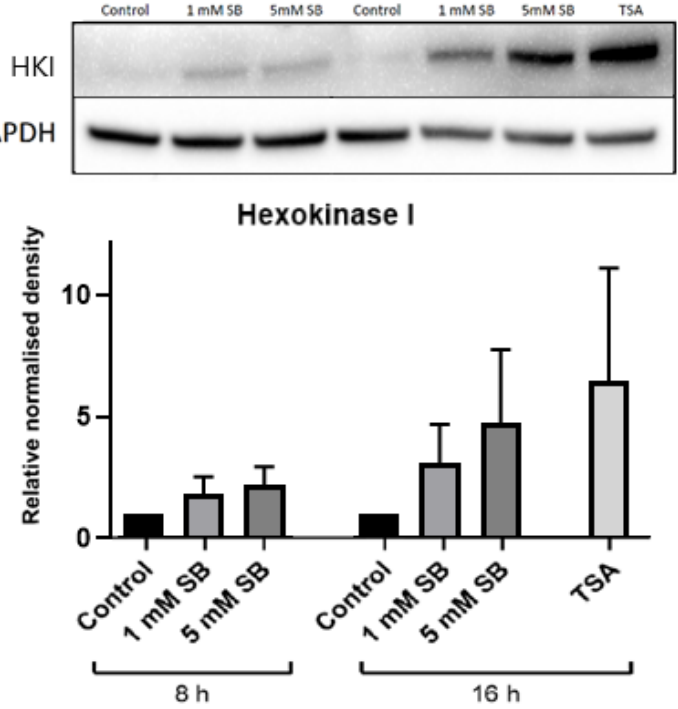
Figure 6. Time-course immunoblot for hexokinase I. Relative protein levels of hexokinase I in HepG2 cells following treatment with 1 mM or 5 mM sodium butyrate for 8 or 16 h or with 2.5 µM TSA for 16 h. The graph represents the mean combined density readings as normalised to GAPDH from three independent experiments, with error bars representing SEMs.